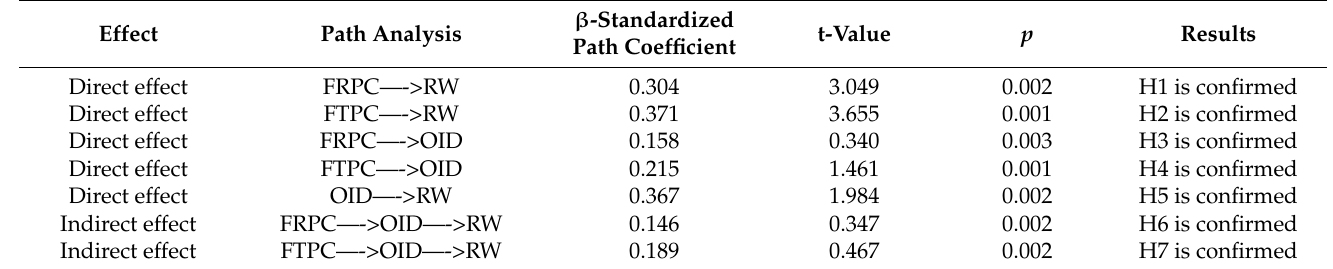
Table 4. Direct effects between variables and mediating effects of the Organizational Identifica- tion (OID) between Fulfillment of the Relational Psychological Contract (FRPC); Fulfillment of the Transactional Psychological Contract (FTPC) and Results of Work